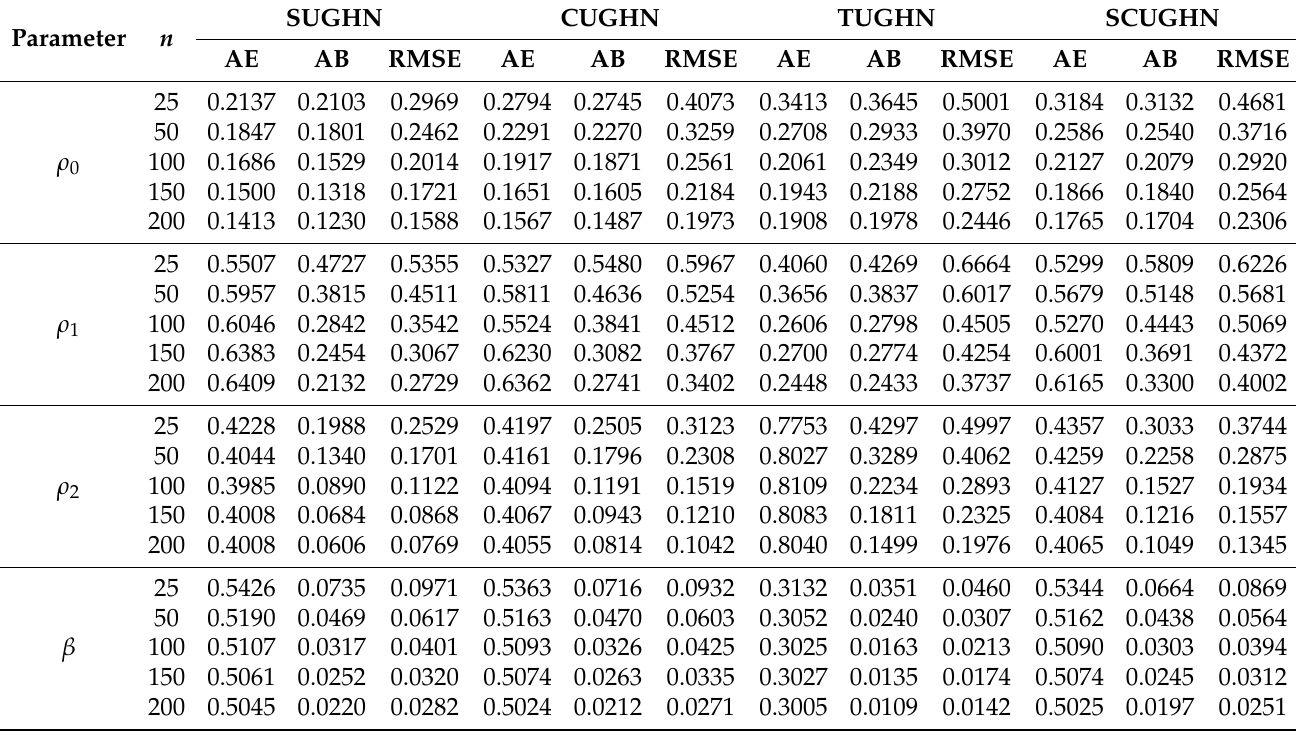
Table 2. Simulations results for ( ρ 0 , ρ 1 , ρ 2 , β ) = ( 0.1,0.7,0.4,0.5 )